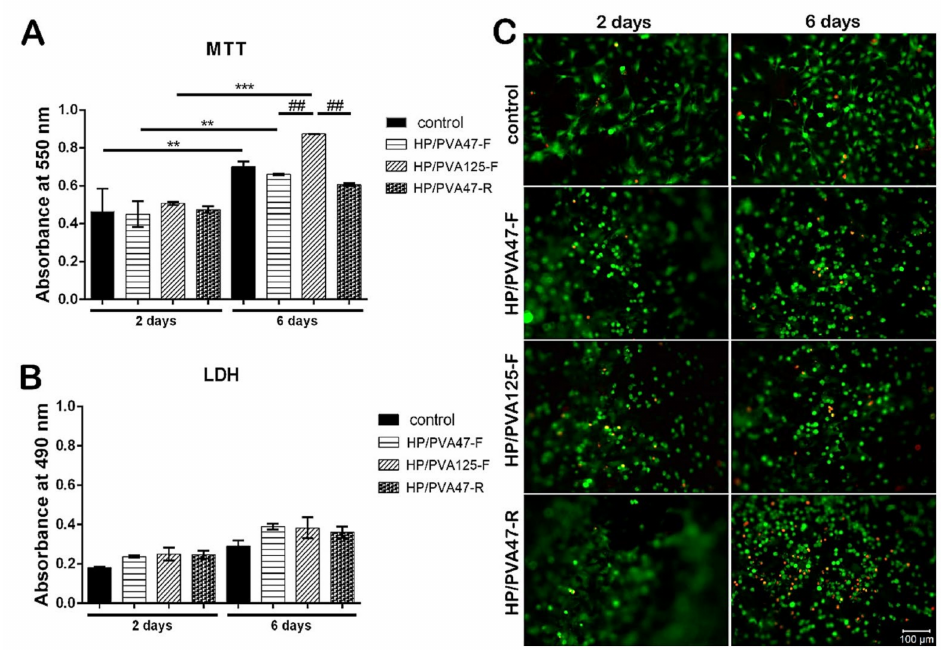
Figure 6. Cell viability and proliferation assessment: ( A ) using MTT assay (** p > 0.01 and *** p > 0.001); ( B ) LDH assay for cytotoxicity evaluation; ( C ) Confocal microscopy: dead (red) and live (green) cells, scale bar 100 µ m using L929 murine fibroblast cells